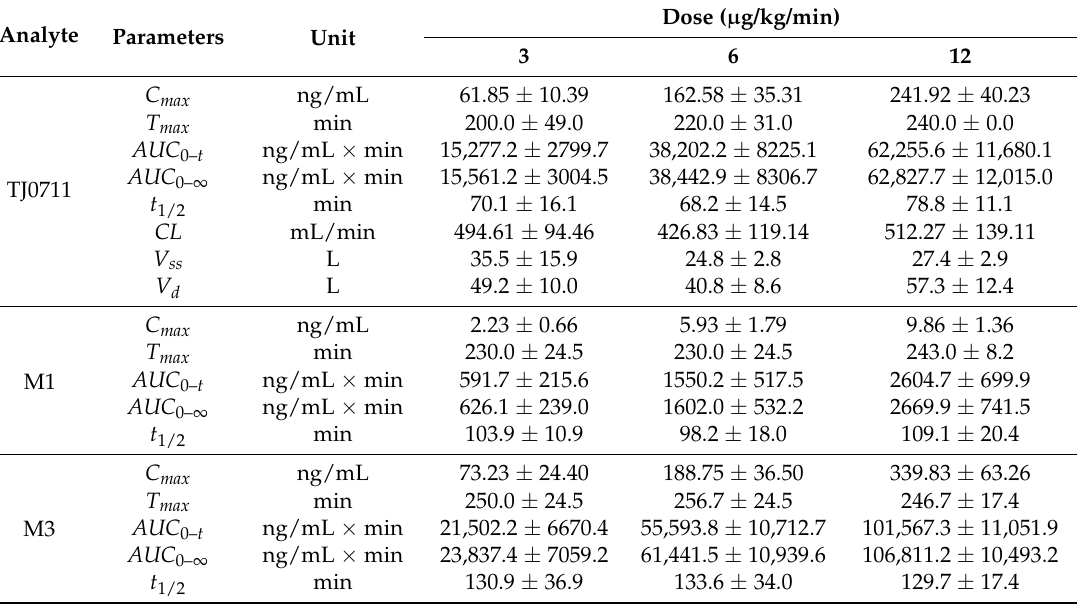
Figure 5. Relationship between ln(PK) and ln(Dose). ( A ) C max , ( B ) AUC 0– ∞ . The full lines are the fitted values calculated by the power model and the dotted lines are the 95% prediction band. Table 5. The pharmacokinetic parameters of TJ0711 after intravenous infusion for 4 h in beagle dogs ( n = 6).